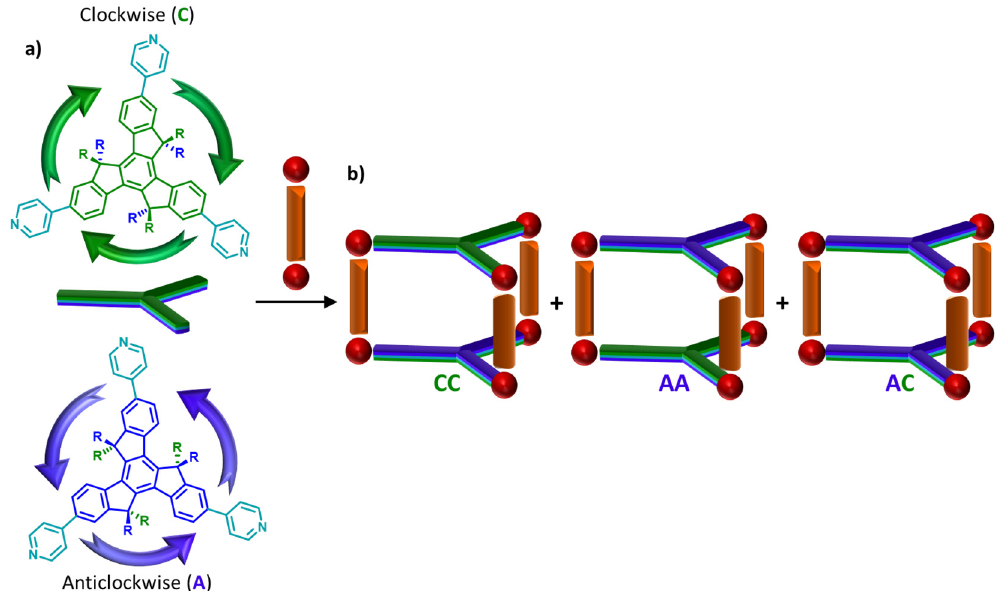
Figure 1. ( a ) Hexa-alkylated truxene-based ligand (L) showing two rotational faces (Clockwise (C), green and Anticlockwise (A), blue); and ( b ) the three possible metalla-cage structures (M 6 L 2 ) that can be obtained upon self-assembling with bis -metallic complexes.